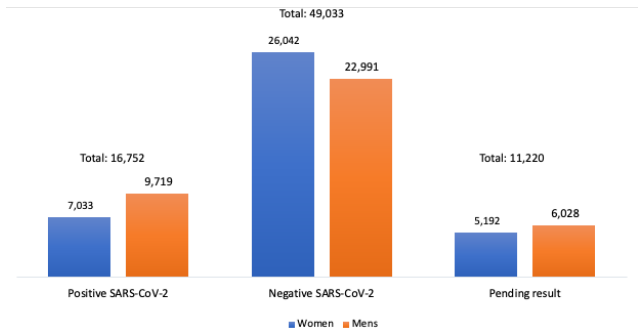
Figure 6. Total cases registered by the epidemiological surveillance system as of April 28, 2020.